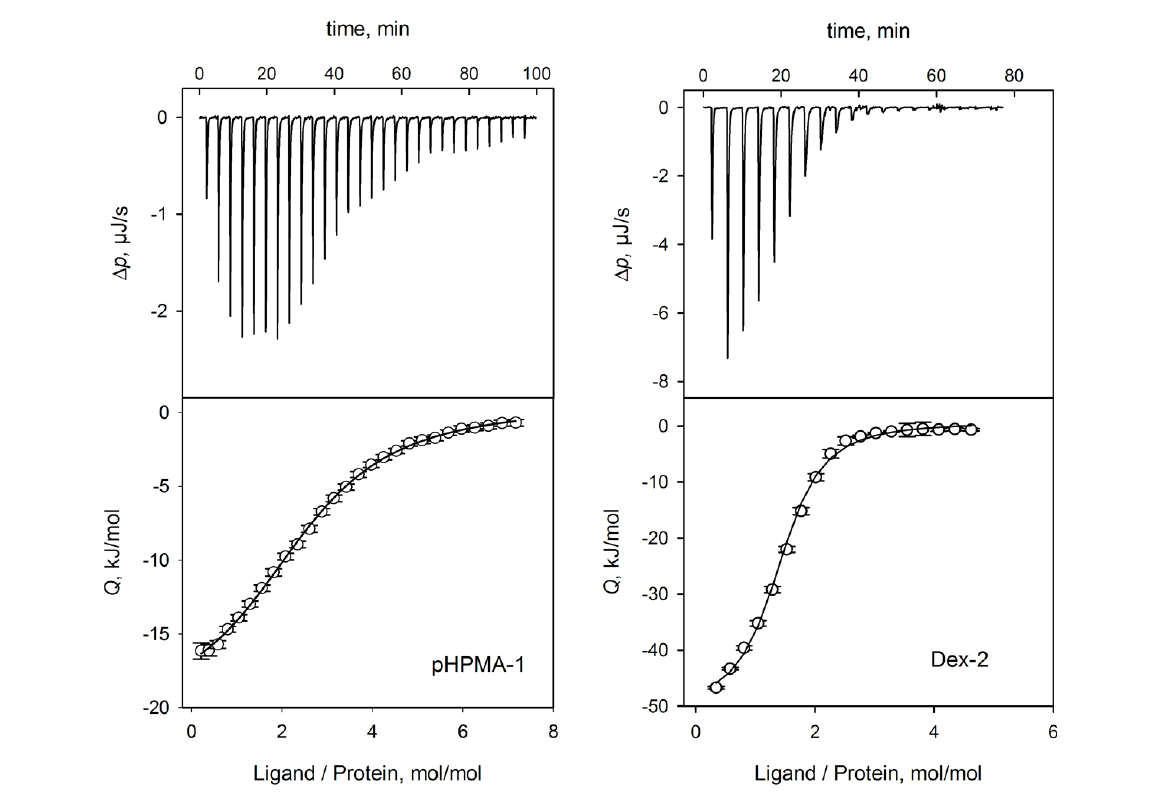
Figure 2: Representative ITC-measurements conducted at 8 °C with the peptide–polymer conjugates A) pHPMA- 1 and B) Dex- 2 showing an increase in affinity for the interaction of Dex- 2 with the FBP21 tandem WW domains. The upper part shows differential heating power ( Δ p ) changes upon injec- tion of peptide–polymer conjugates into the protein; bottom part shows integrated and normalized heat of reaction plotted against peptide/protein molar ratio; binding isotherms are fitted with a 1:1 binding